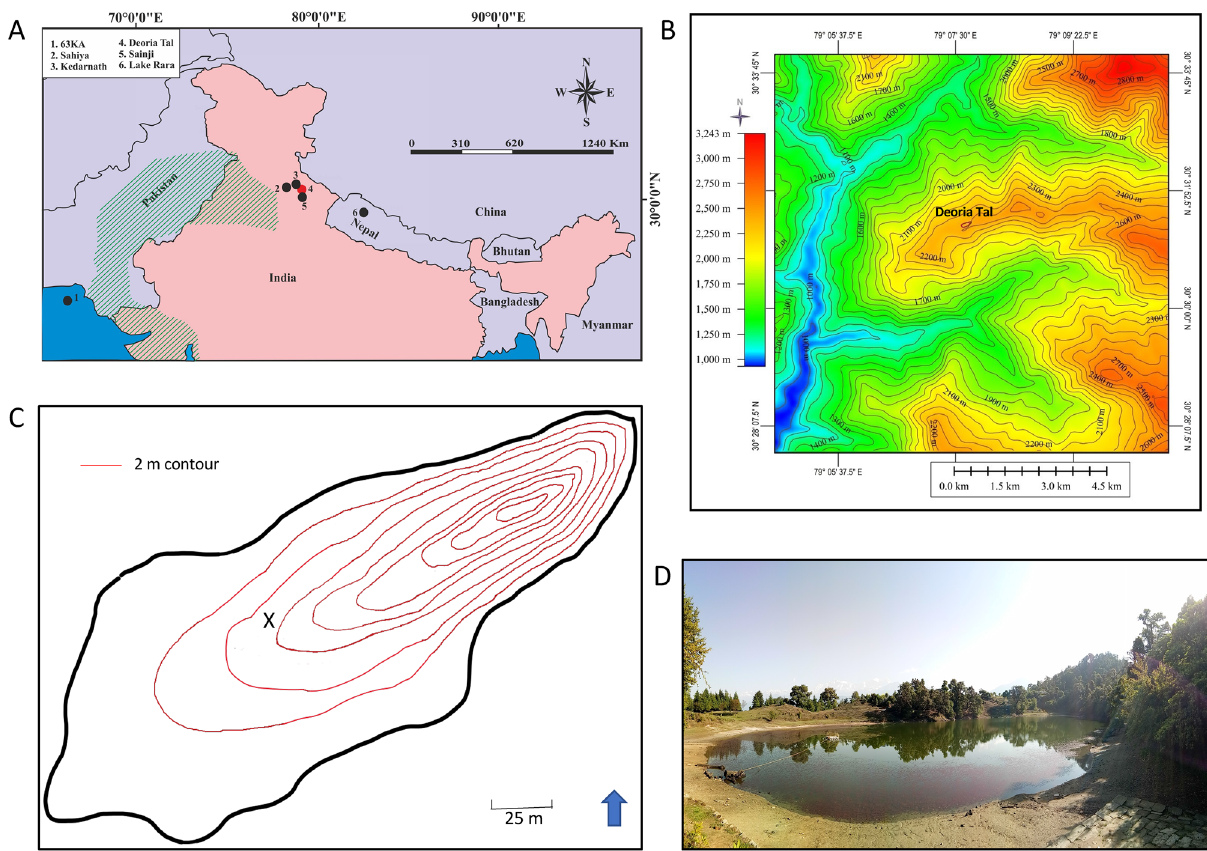
Figure 1. Study area. ( A ) Location of records discussed in text: 63KA 11 ; Sahiya Cave 4 ; Kedarnath Peat Sequence 12 ; Deoria Tal (this study); Sainji Cave 13 ; Lake Rara 14 and the spatial extent of the Indus Civilization (green hatching). ( B ) Topographic context for Deoria Tal (outlined in red). ( C ) Estimated bathymetry of the lake (determined by weighted sounder and based on sketch map created in the field) and the coring location (X). ( D ) Photo of Deoria Tal illustrating the location of Trapa in the littoral of the lake, the coring platform, and the snow-covered peaks of the Himalaya in the background. ( A ) and ( B ) were created using Corel Draw Graphics Suite (version × 8; www. corel. com). ( C ) was created using Adobe Photoshop CC (version 20; https:// www. adobe. com/ produ cts/ photo shop.